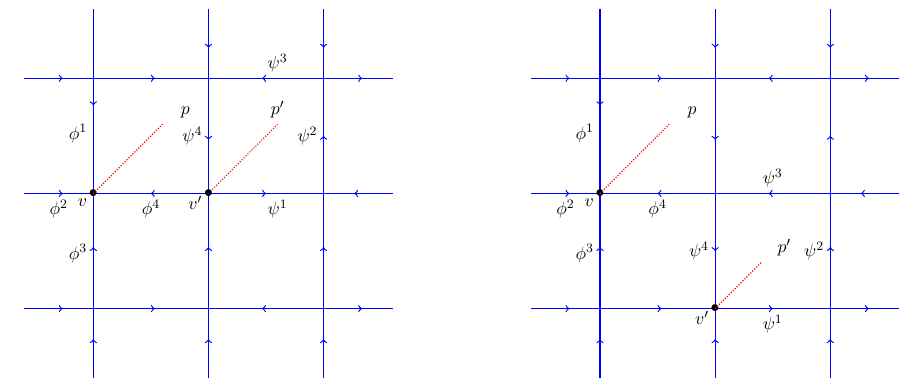
Figure 5 . Diagram depicting two different graphs each with disjoint sites ( v, p ) and ( v 0 , p 0 ) . faces p and q are allowed leading to p and q adjacent to each other as illustrated by the graph on the left of figure 5. The second graph on the right of figure 5 however has no edges common to both